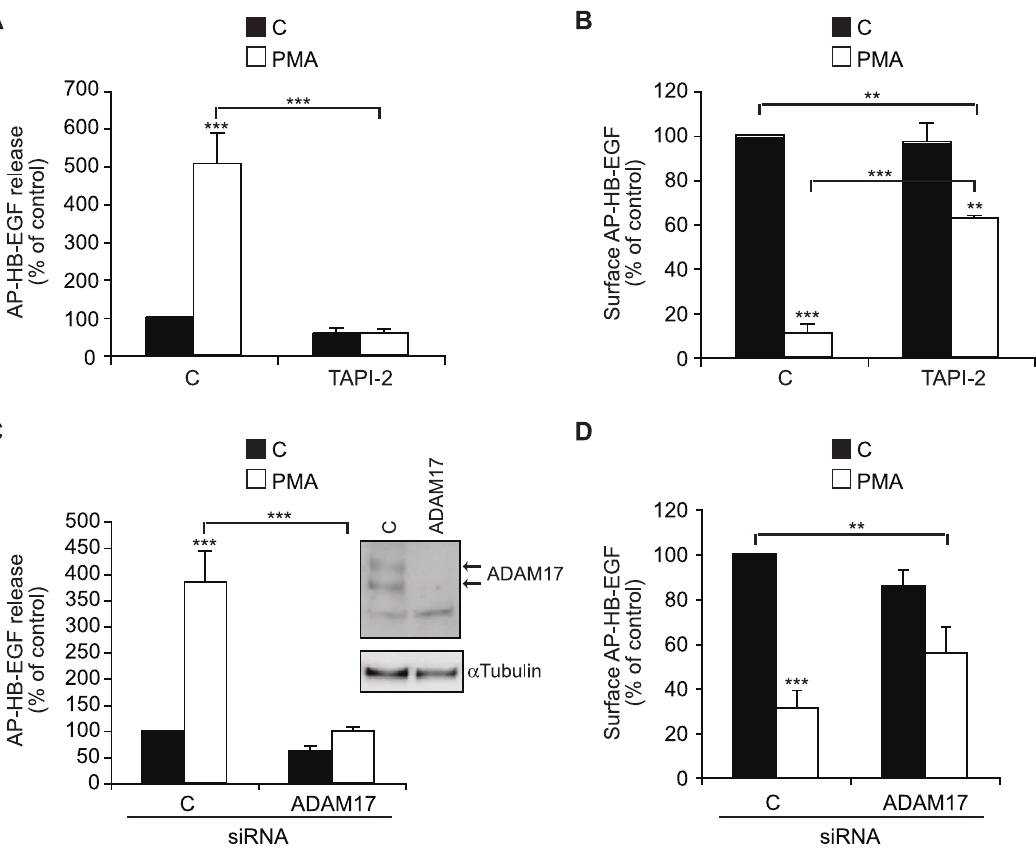
Figure 2. PMA-induced HB-EGF shedding is ADAM17-dependent. A ) AP-HB-EGF release measured as alkaline phosphatase activity (OD 405 nm) in conditioned media and B ) surface AP-HB-EGF measured as cell surface fluorescence intensity per cell (FLU/cell) in DMSO control-treated (C; black bars) and 30 min, 400 nM PMA-treated (PMA; white bars) AP-HB-EGF expressing HT1080 cells treated with the ADAM17 inhibitor TAPI-2 (10 m M) or vehicle control. C, D ) as in A and B respectively, except that cells were reverse transfected with control (C) or ADAM17 siRNAs for 72 h before treatment. The insert shows western blot analysis of total cell extracts from cells used in C and D, demonstrating efficient siRNA-mediated knockdown of pro and mature forms (arrows) of ADAM17. a -tubulin is used as an internal loading control. All graphs show average values 6 standard error of the mean of at least three independent experiments each done in triplicate. *p , 0.05; **p , 0.01, ***p , 0.001 after one-way analysis of variance with Bonferroni’s post tests for multiple comparisons. Unless otherwise indicated the comparison is relative to the respective